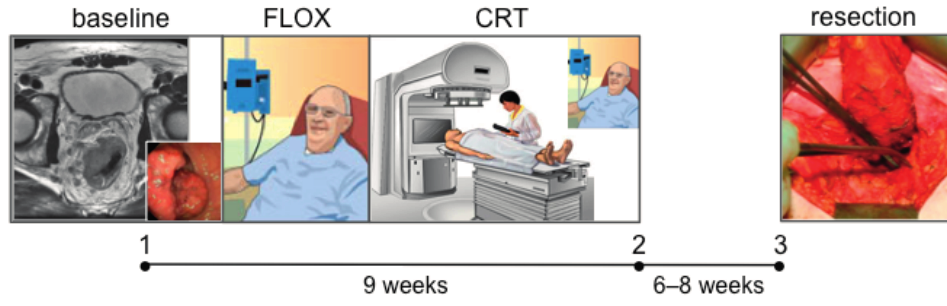
Figure 2. Locally Advanced Rectal Cancer—Radiation Response Prediction: design of the circulating biomarker study. Serum samples (denoted by closed circles) were collected at baseline ( i.e. , the time of diagnosis with rectal endoscopy and magnetic resonance imaging of the pelvic cavity; 1), following FLOX chemotherapy and chemoradiotherapy (CRT; 2), and before resection of the residual primary tumor (3). Treatment toxicity, assessed as detailed in Section 3, was recorded immediately following the completion of neoadjuvant treatment and repeatedly before the surgery. Images are from own work or adapted with permission